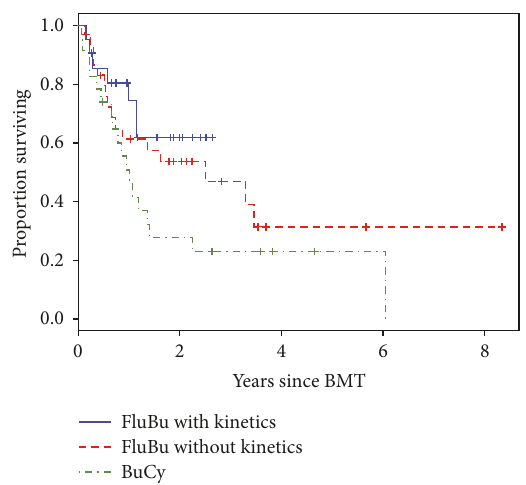
Figure 2: Kaplan-Meier curve for overall survival for allogeneic hematopoietic cell transplantation by conditioning regimen ( 𝑃 = .11). BMT, bone marrow transplant; Bu, busulfan; Cy, cyclophos- phamide; Flu,